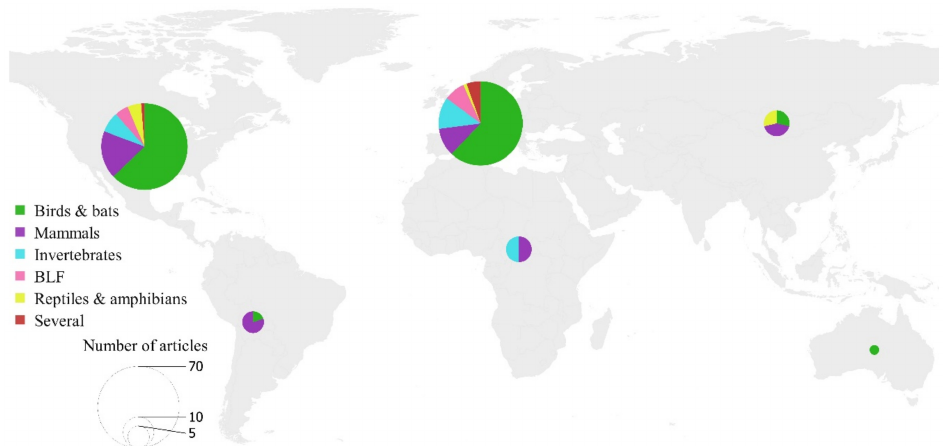
Figure 2. Number of articles per continent (size of the circle) found in the literature search (2000–2020) that relate to metrics based on LiDAR with the studied taxonomic groups and the proportion of articles of these taxonomic groups by continent. BLF: Bryophytes, lichens, and fungi; Several: studies including more than one taxonomic group. See main text for more